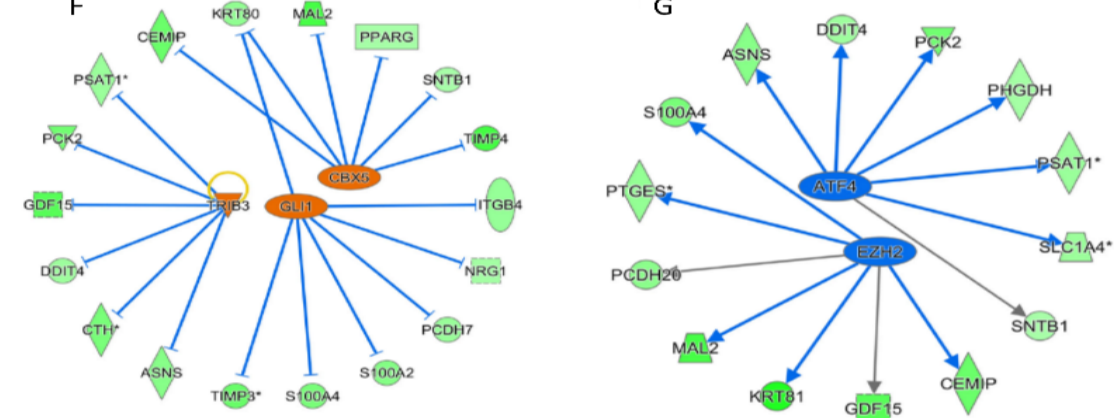
Figure 5. Effector analysis of differentially regulated gene transcripts in FSCN1 KD MDA-MB-231 breast cancer cells. ( A ) Tree map (hierarchical heat map) depicting affected functional categories based on differentially expressed genes in FSCN1 KD compared to FSCN1 CON MDA-MB-231 cells where the major boxes represent a category of diseases and functions. Each colored rectangle is a particular biological function or disease and the color range indicates its predicted activation state—increasing (orange) or decreasing (blue). Darker colors indicate higher absolute Z-scores. In this default view, the size of the rectangles is correlated with increasing overlap significance. Live cell assays showing migration ( B ), invasion ( C ), proliferation ( D ) and adhesion to collagen IV ( E ) in FSCN1 KD compared to FSCN1 CON MDA-MB-231 cells. Results in B-E are the mean of triplicates ± SD and are representative of three independent experiments. Upstream regulator analysis depicted activated GLI1, CBX5 and TRIB3 ( F ) and suppressed EZH2 and ATF4 ( G ) networks based on IPA analysis of data in Table S1.